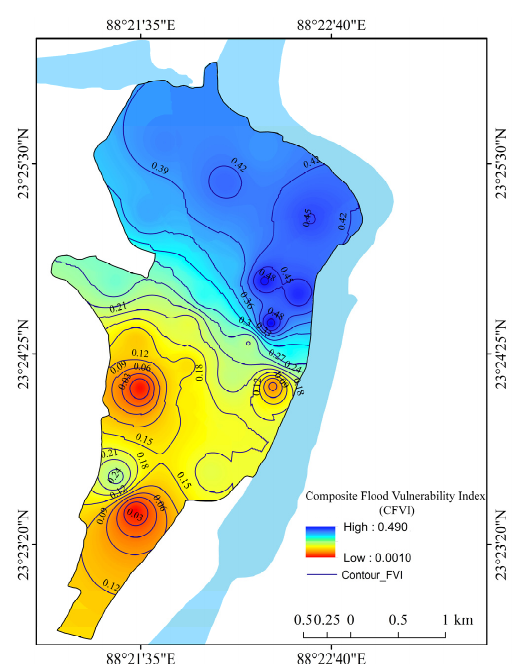
Figure 46. Isoline of CFVI (2000).